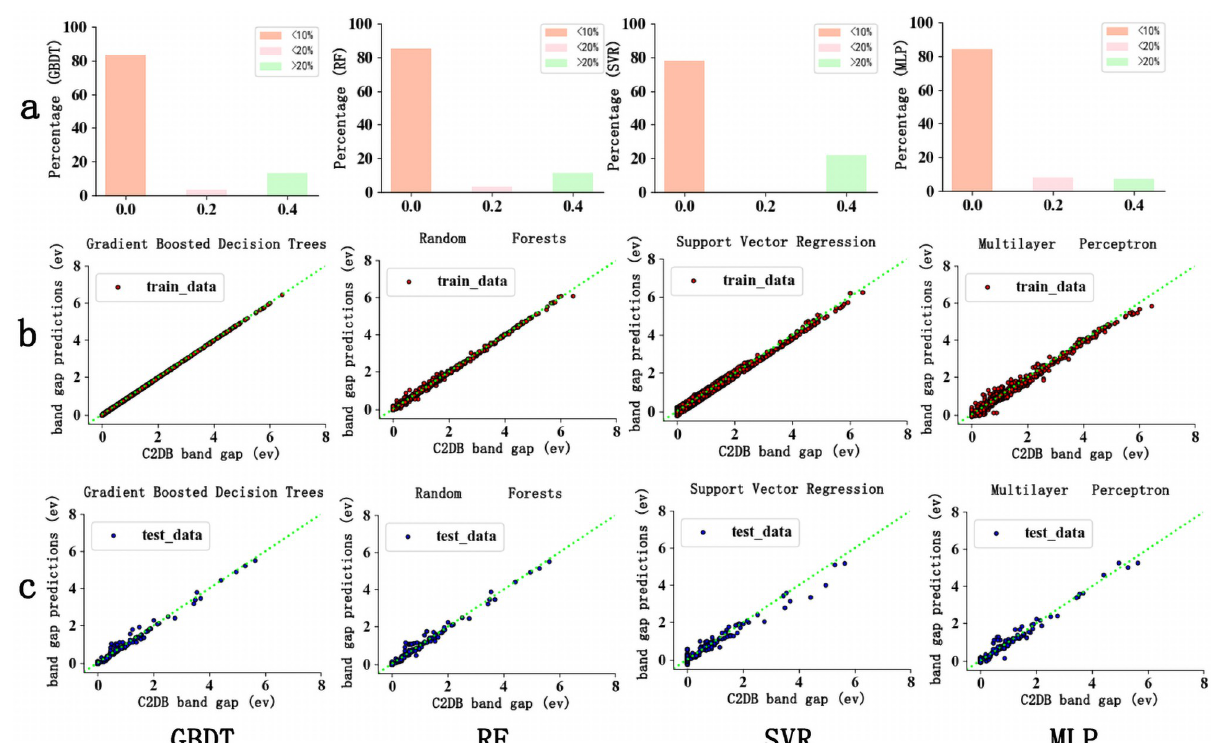
Fig 4. Prediction performance of four ML algorithms (GBDT, RF, SVR and MLP) with the feature Gap_nosoc. (a) Error levels of ML predicted bandgaps (b) Fitness between predicted bandgaps and true bandgaps on the training sets (c) Fitness between predicted bandgaps and true bandgaps on the test